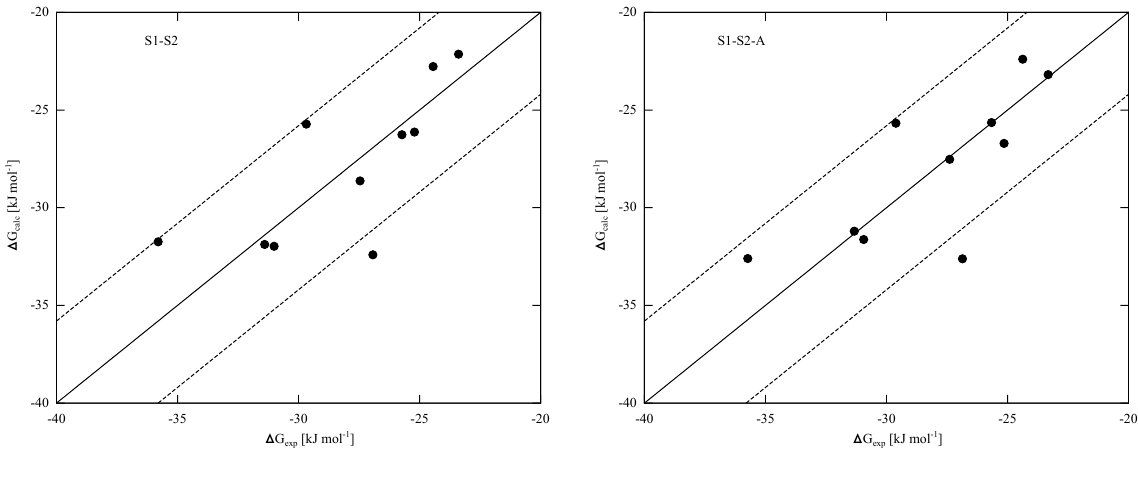
) and experimental ( ∆ G ) binding free calc exp and ∆ G , exp calc 4.184 kJ mol − 1 (1 kcal mol − 1 ). ±